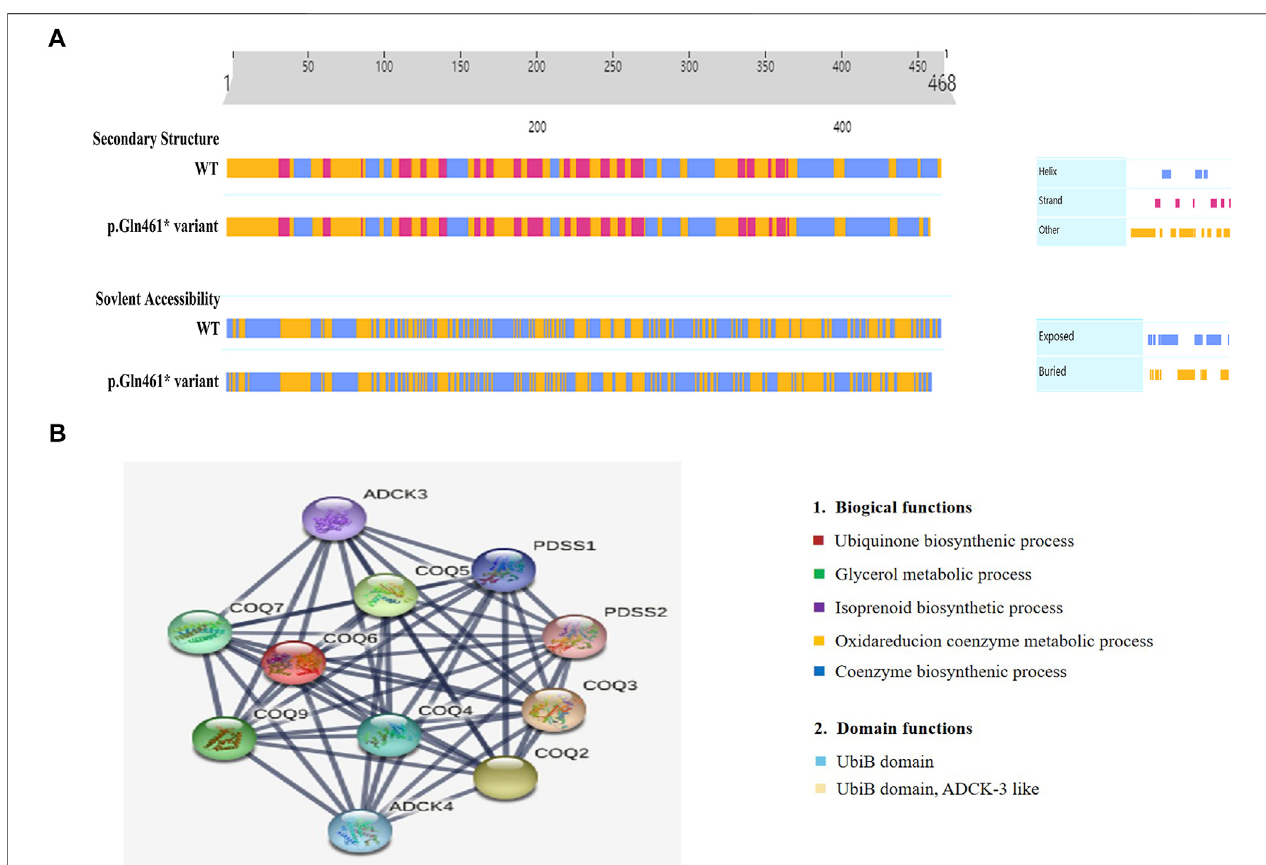
FIGURE4| Secondarystructure analysisofthe COQ6 protein andSTRING networkanalysis. (A) Secondarystructureandsolventaccessibility ofwild-type COQ6 and the protein with the candidate variant (p.Gln461Ter) were analyzed using the PredictProtein online database. (B) The functional association of the COQ6 with other proteins involved in the pathway of CoQ10 biosynthesis was predicted by STRING network analysis (STRING v11.0, https://stringdb.org/).